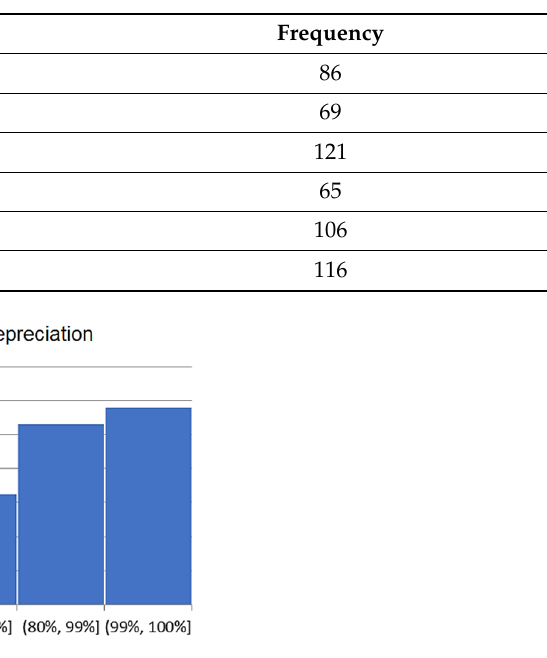
Table 9. Accumulated asset depreciation histogram data.